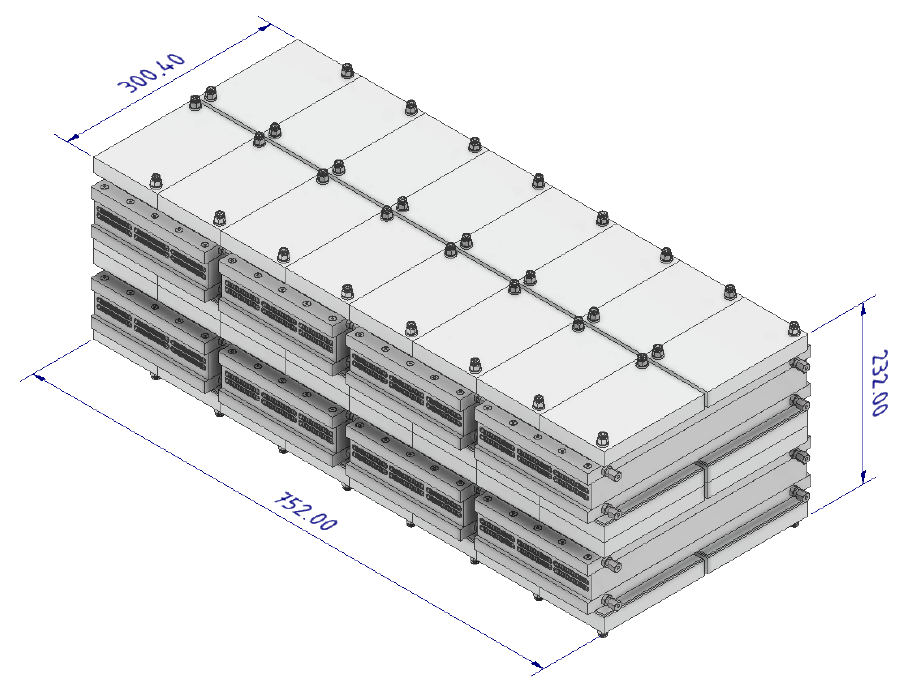
Figure 6. Proposed system CAD model (dimensions in